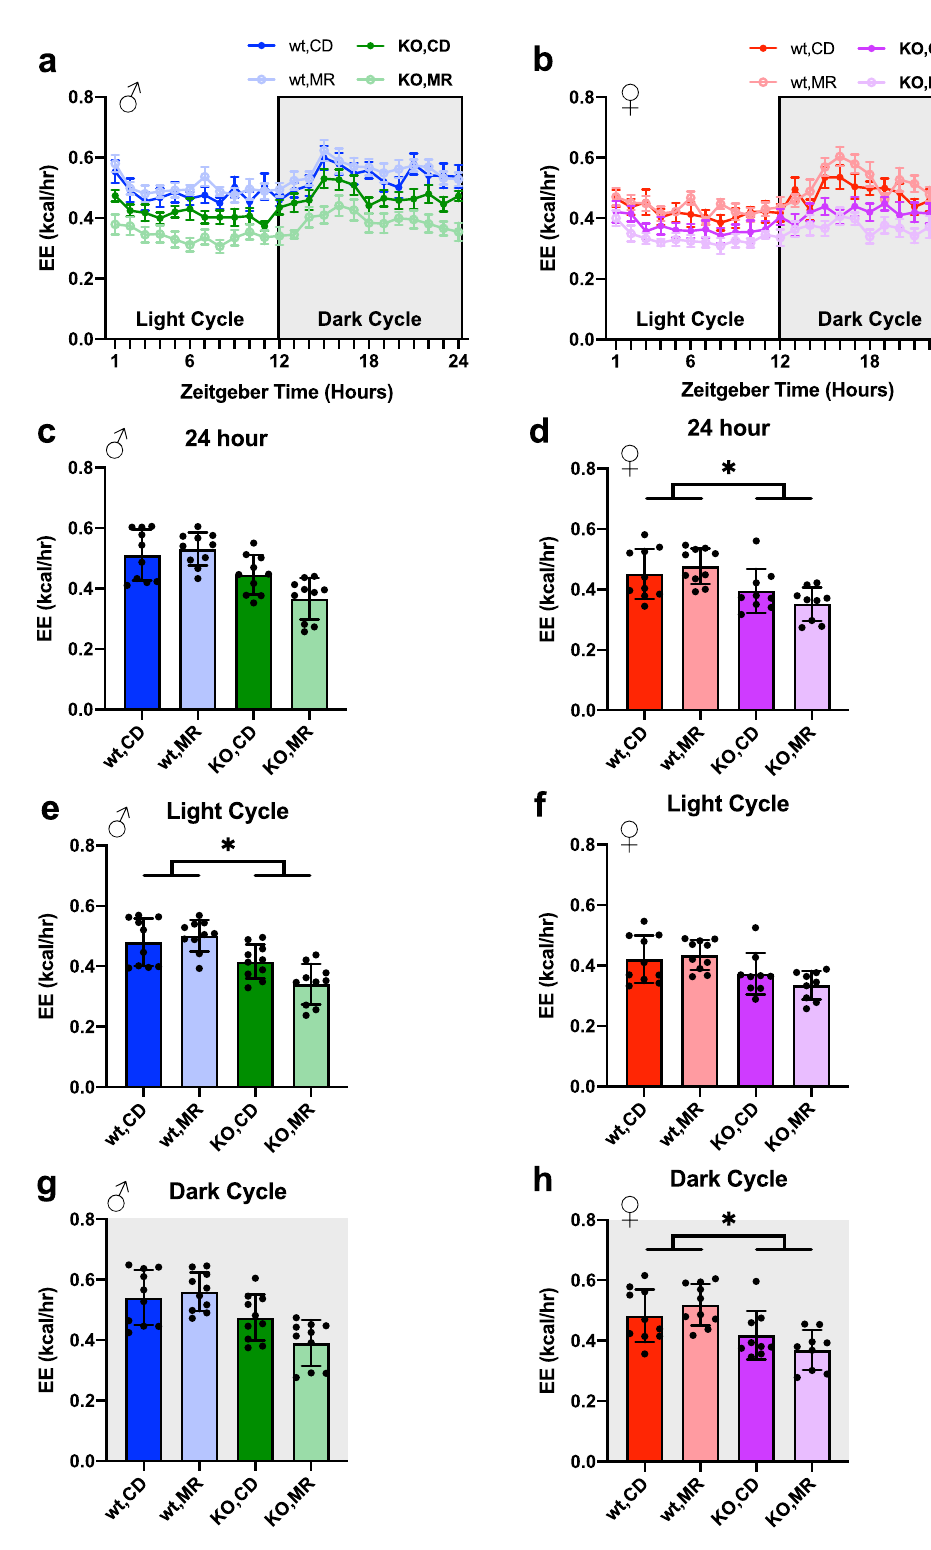
Figure 6. Energy Expenditure was not impacted by MR. Energy Expenditure (EE) for 24 h period based on VO2 not normalized to mass for mice from Cohort 2 ( a ), ( b ). Data averaged over the 24 h test period ( c ), ( d ), and for the light ( e ), ( f ) and dark ( g ), ( h ) cycle separately. Analyzed with ANCOVA using lean mass as a control variable for AUC graphs of EE for full 24 h as well as light and dark cycles. Line graph represents mean ± s.e.m., bar graphs represent mean ± s.d. Groups were 9–10 mice. (* p <